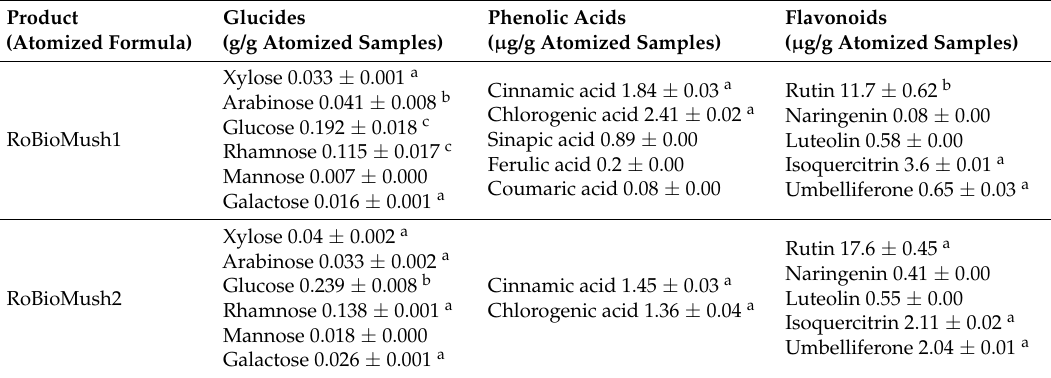
Table 1. The main bioactive compounds of the two functional